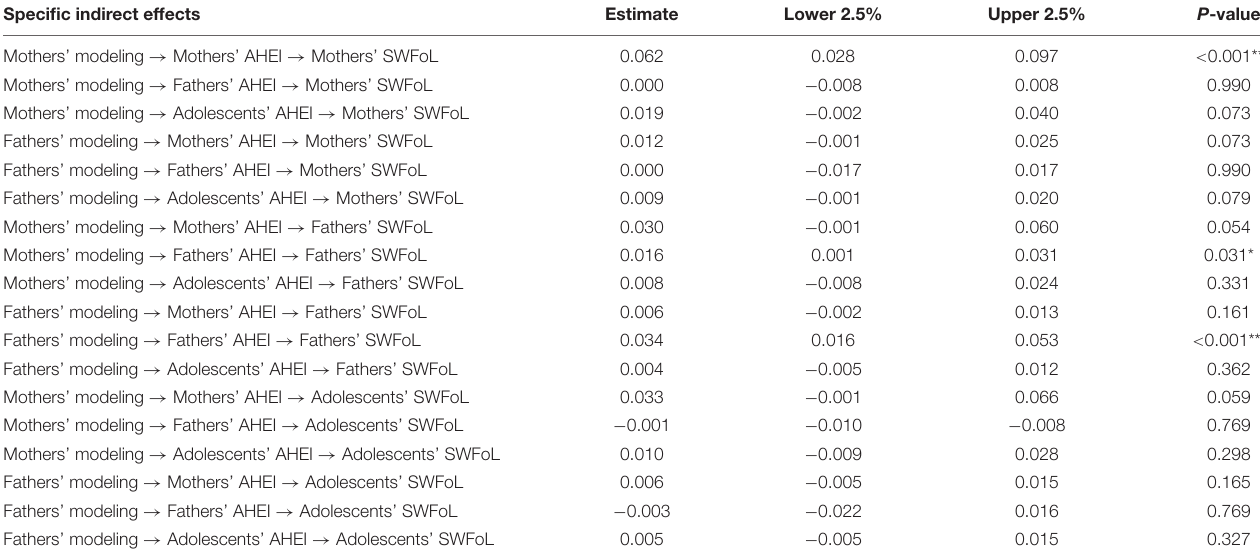
TABLE 3 | Bias-corrected confidence intervals of specific mediation effects of the three family members’ diet quality (measured by the Adapted Healthy Eating Index,